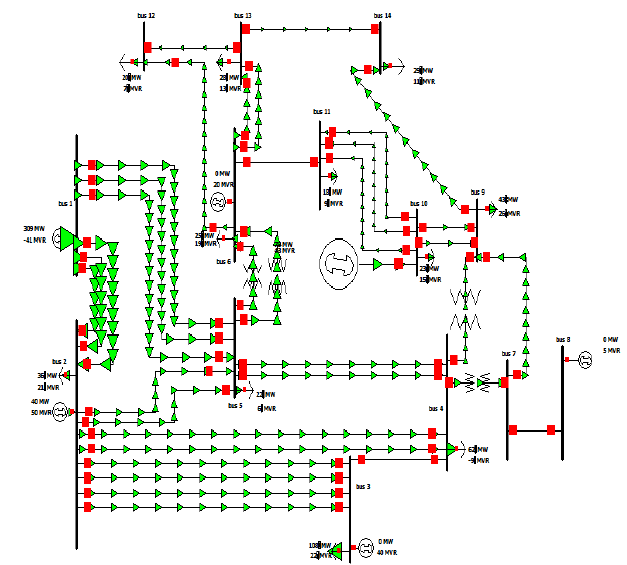
Fig3. Network with new alternate lines